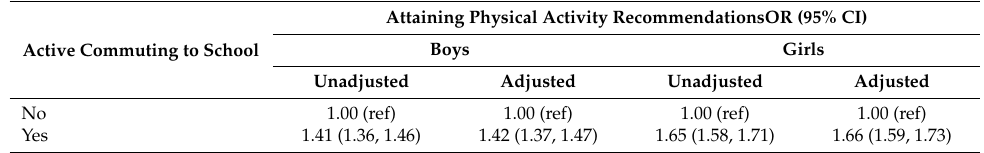
Table 4. Odds ratio for attaining the physical activity recommendations according to active commuting to